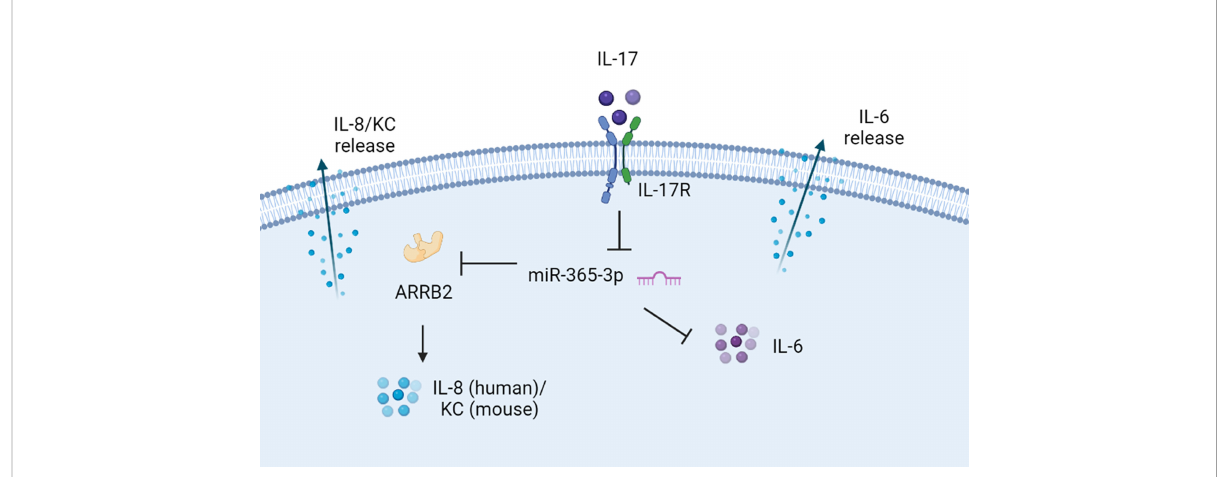
FIGURE 7 The proposed scheme of negative regulating role of miR-365-3p in IL-17 induced KC and IL-6 production. miR-365-3p, which was diminished by IL-17 in murine and human asthmatic pathogenesis, functioned as an essential negative mediator to suppress IL8 (KC for mouse) and IL-6 upon IL-17 stimulation by targeting